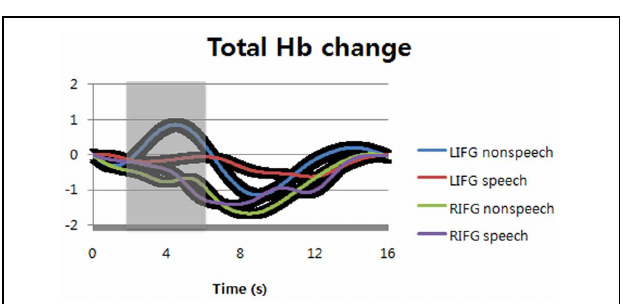
FIGURE 4 | Total hemoglobin changes at bilateral inferior frontal gyri (normalized as the scale of canonical hemodynamic response function with a range from 0 to 1). The black regions surrounding the signals show standard deviation. LIFG, left inferior frontal gyrus; RIFG, right inferior frontal